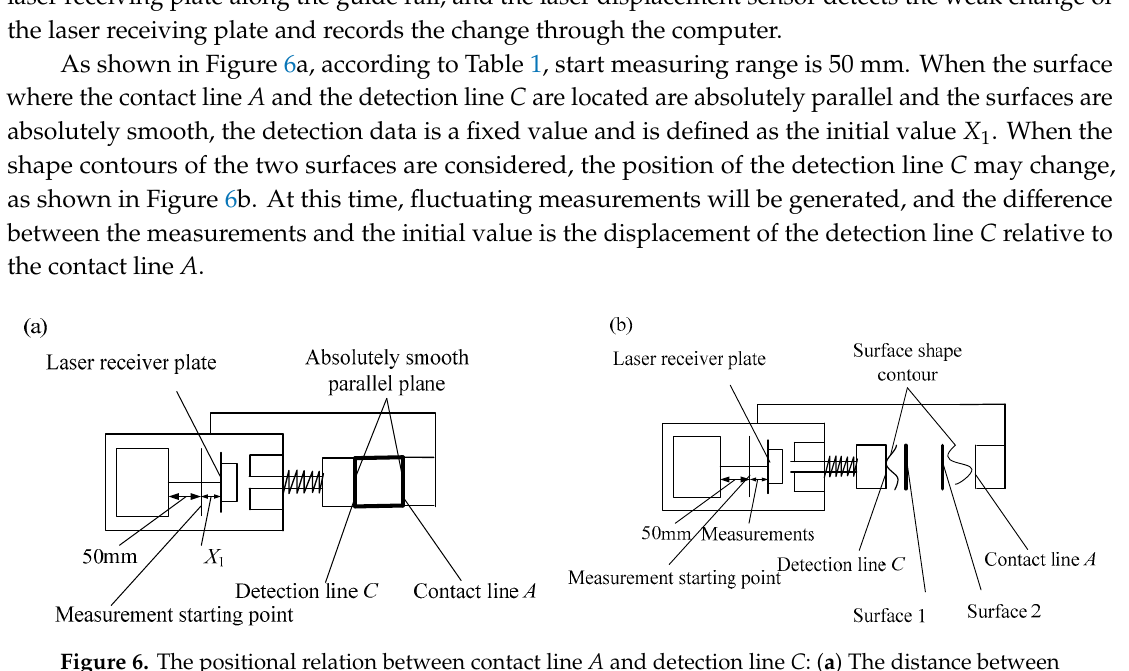
Figure 7. Detection model of two horizontal parallel surfaces.